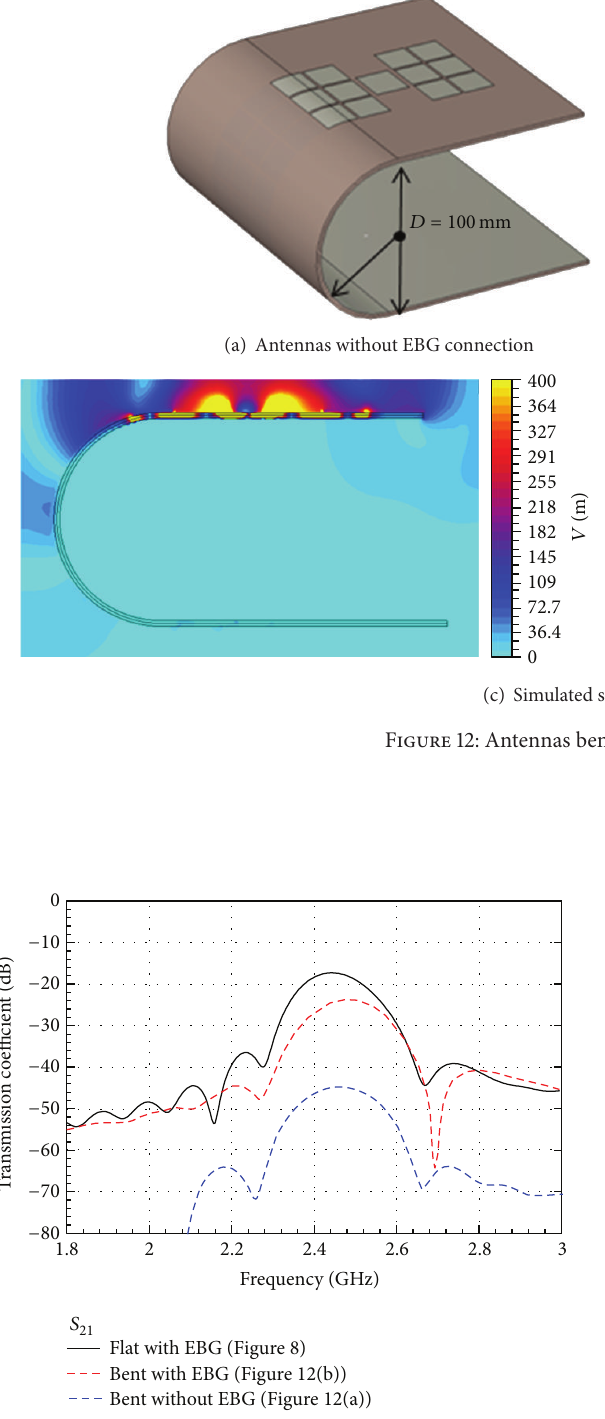
Figure 13: Transmission coefficients S 21 for bent antenna